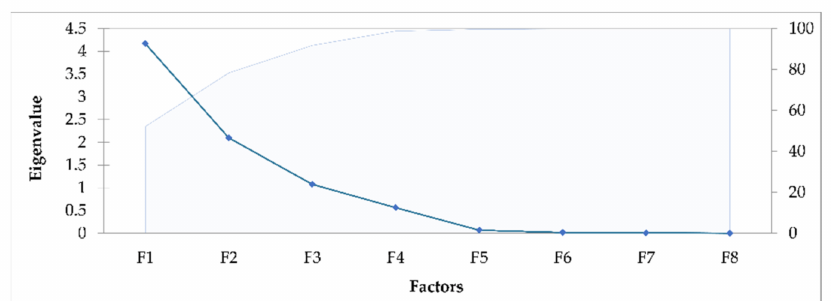
Figure 12. Screen plot of the eigenvalues after principal component analysis. Source: Author’s contribution based on data retrieved from Eurostat. Annual enterprise statistics for special aggregates of activities. https://appsso.eurostat.ec.europa.eu/nui/show.do?dataset=sbs_na_sca_r2&lang=en, accessed on 9 January 2022.